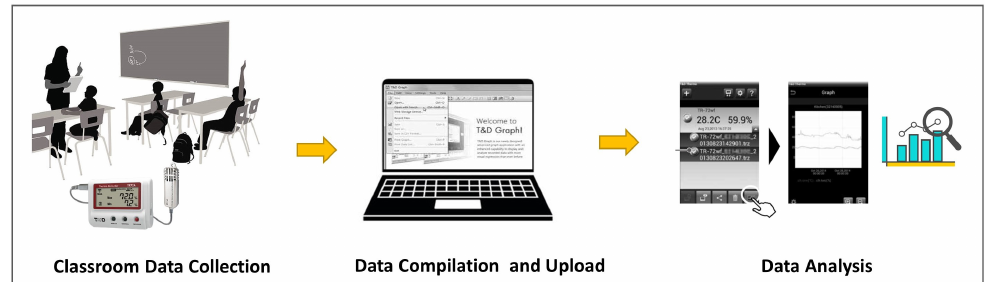
Figure 5. High-level process for machine learning-based